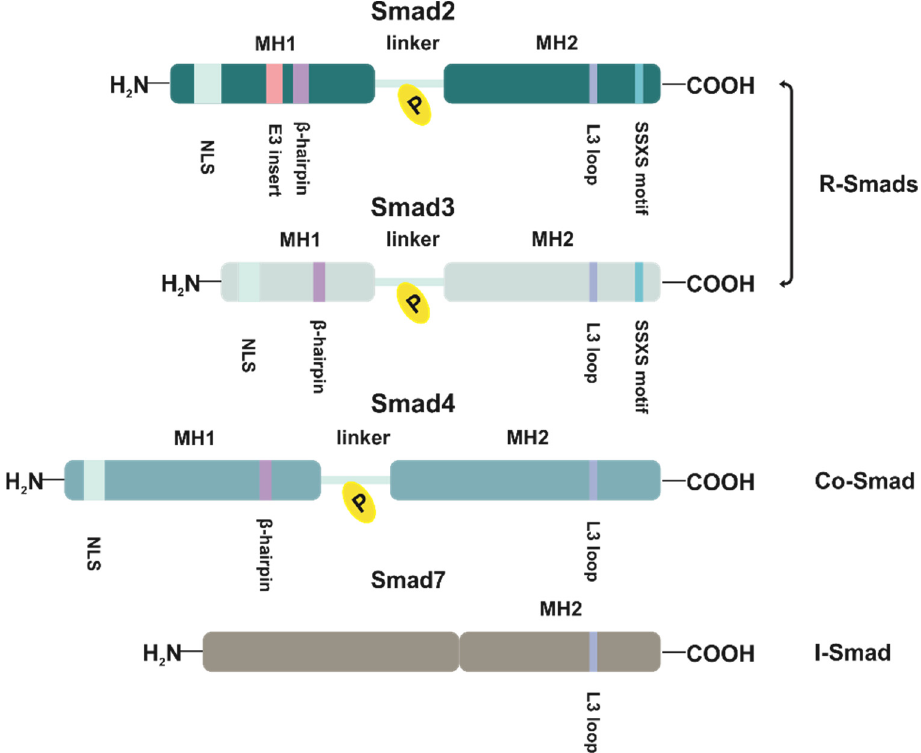
Figure 3. Smad proteins engaged in the canonical TGF β pathway. Schematic representation structure of receptor-activated Smads (R-Smads), common-mediator Smad (Co-Smad), and inhibitory-Smad (I-Smad) necessary for TGF β isoforms-induced canonical signaling. MH1 and MH 2: Mad homology 1 and 2 domains; NLS: nuclear localization signal; SSXS: Ser-Ser-X-Ser motif.